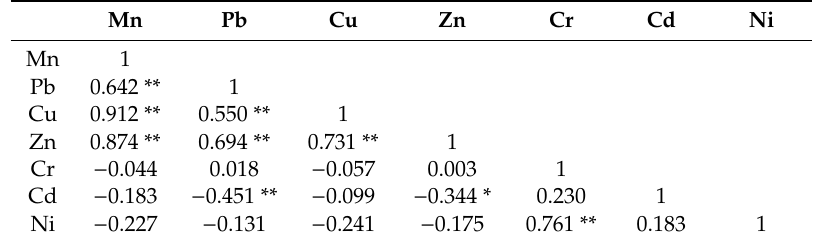
Table 3. Pearson correlation coe ffi cient matrix between PTEs in the soil. Mn Pb Cu Zn Cr Cd Ni Mn 1 Pb 0.642 ** 1 Cu 0.912 ** 0.550 ** 1 Zn 0.874 ** 0.694 ** 0.731 ** 1 − 0.044 0.018 0.003 1 Cd − 0.183 − 0.451 ** − 0.099 − 0.344 * 0.230 1 Ni − 0.227 − 0.131 − 0.241 − 0.175 0.761 ** 0.183 1 ** indicates that the correlation reached a significant level of 0.01 (two-tailed), * indicates that the correlation reached a significant level of 0.05